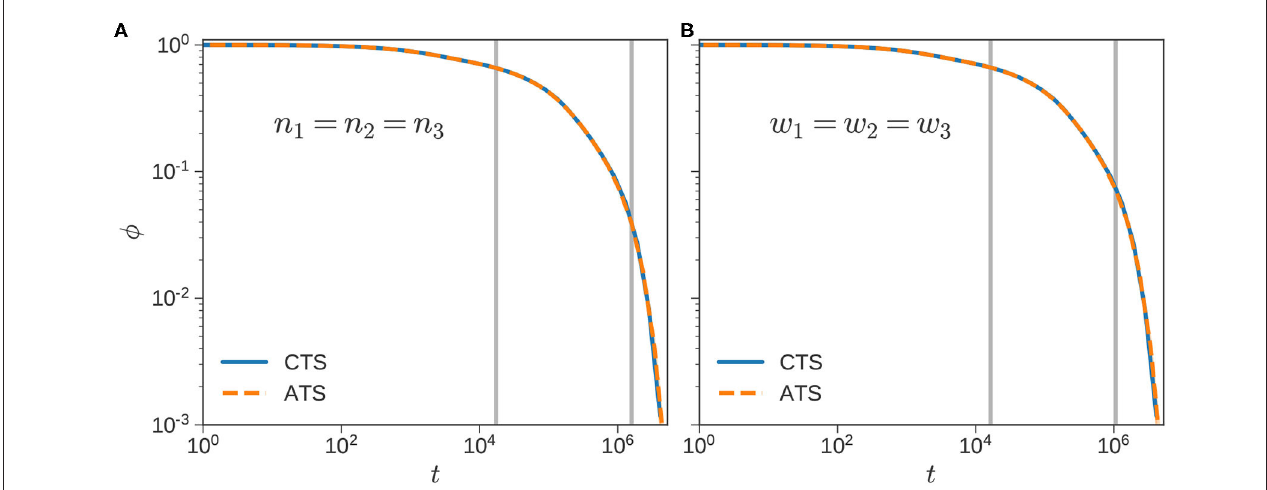
FIGURE 9 | Ternary blends. Normalized stress relaxation curves using the CTS (blue) and ATS (dashed orange) algorithms for ternary blends with ( ¯ Z 1 , ¯ Z 2 , ¯ Z 3 ) = (10,40,80). The number and weight fractions of the components are equal in (A,B) , respectively. The gray lines mark τ ∗ 1 and τ ∗ 2 in both subfigures mark the times at which components 1 and 2 relax completely.